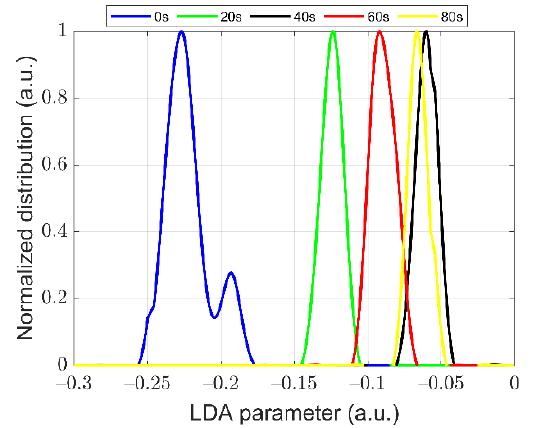
Figure 6. The distribution of LDA parameter of samples with different ST times.